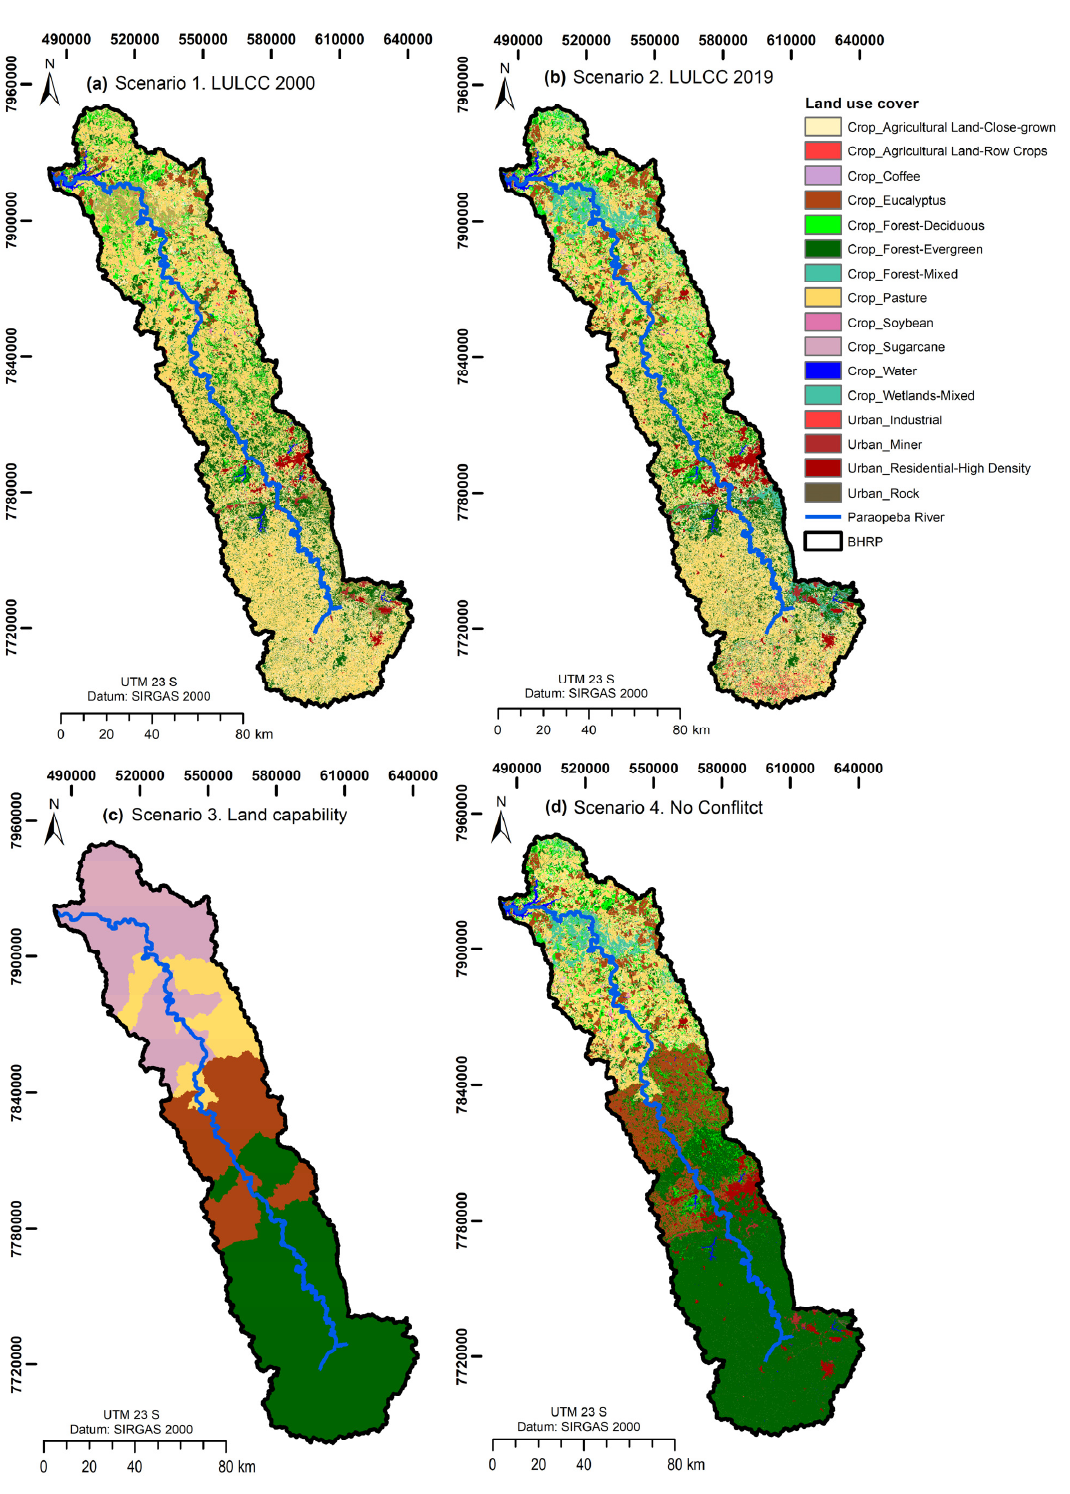
Figure 7. ( a ) Scenario 1—LULCC 2000; ( b ) scenario 2—LULCC 2019; ( c ) scenario 3—Capability land of PRB; ( d ) scenario 4—No Conflict Land